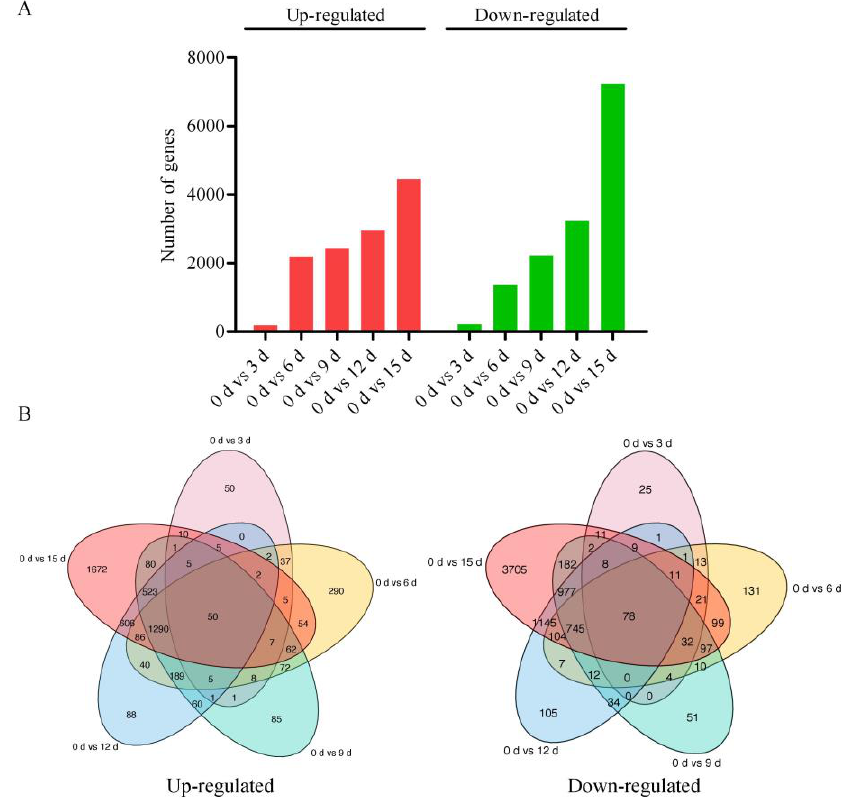
Figure 2. Statistical results of DEGs in pecan seedlings under drought stress. ( A ) The numbers of DEGs in the transcriptome sequencing data of pecan seedlings under drought treatment. The red bar indicates up-regulated DEGs, and the green bar indicates down-regulated DEGs. ( B ) Venn diagram displaying the numbers of overlapping genes at different timepoints.